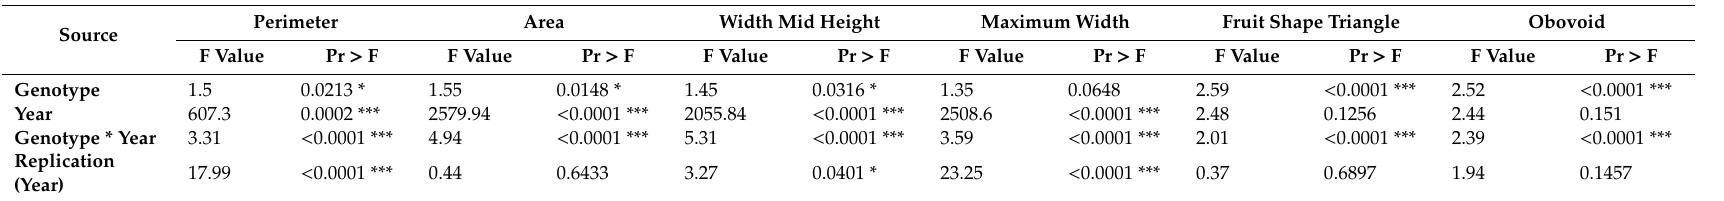
Table 4. Source of variation for the phenotypes observed for the traits with detected quantitative trait loci